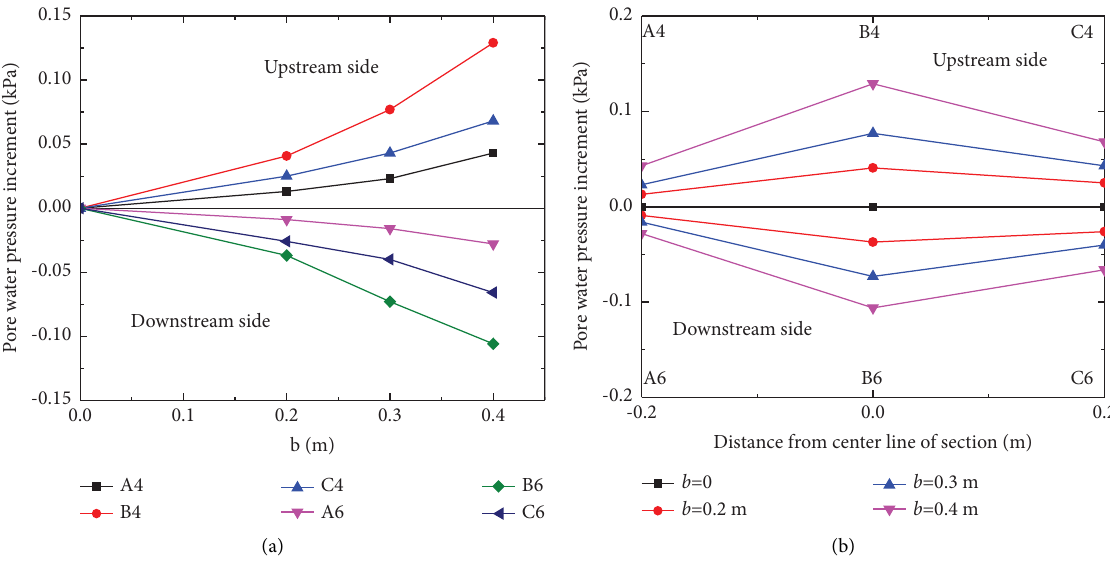
Figure 4: Variation in the pore water pressure increment at two sides of the structure. (a) Variation in pore water pressure increment with the width of the structure. (b) Distribution of pore pressure at both sides of the